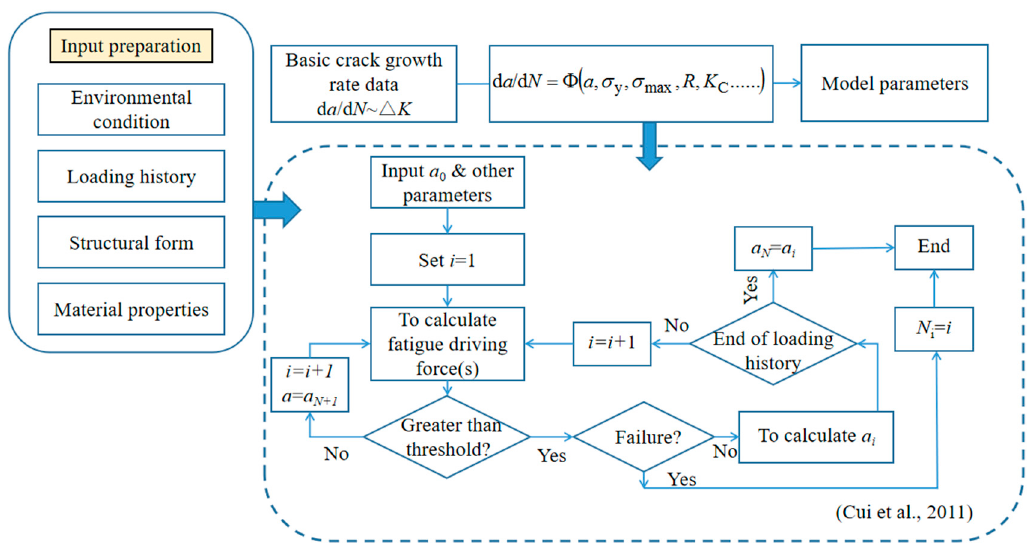
Figure 2. The general procedure of unified fatigue life prediction (UFLP).